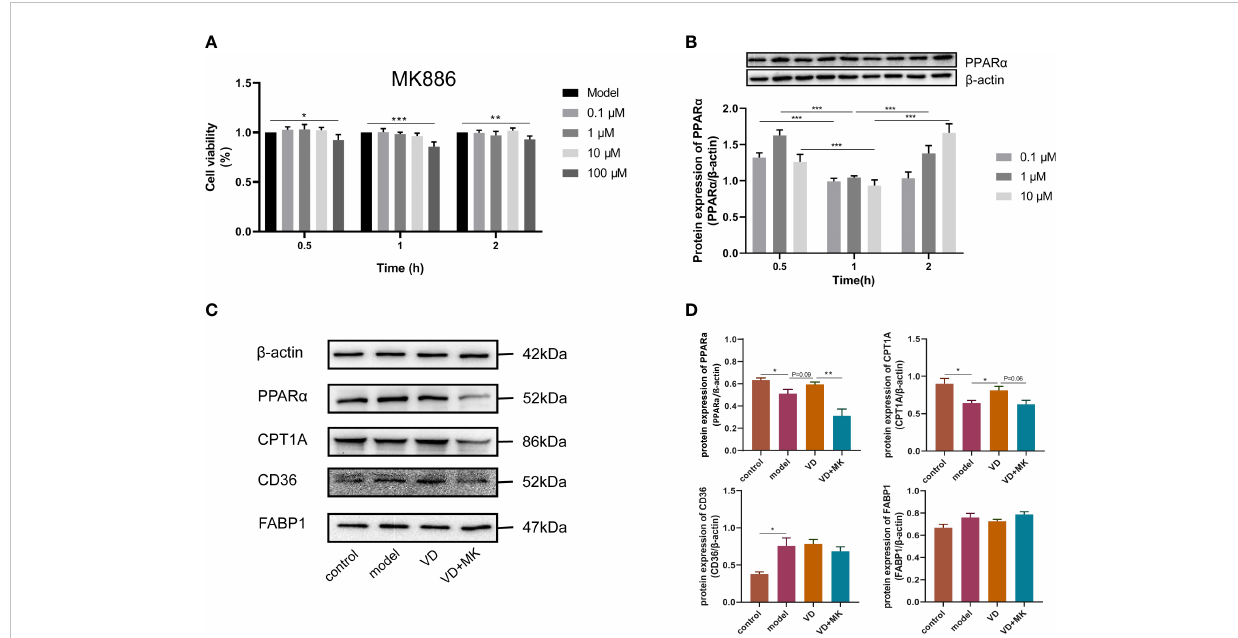
FIGURE 6 MK886 restrain the effect of VD treatment. (A) The cytotoxic effect after MK886 (0-100 m M) for 0-2h was evaluated by CCK8 assay. (B) The best inhibiting effect after MK886 (0-10 m M) for 0-2h was determined by western blot. (C, D) Effect of VD and MK886 on the protein expression involved in fatty acid uptake and b -oxidation, including PPAR a , CPT1A, FABP1, CD36. The band intensity ratios were analyzed by ImageJ. Data are shown as means ± SEM. *P < 0.05, **P < 0.01, ***P <